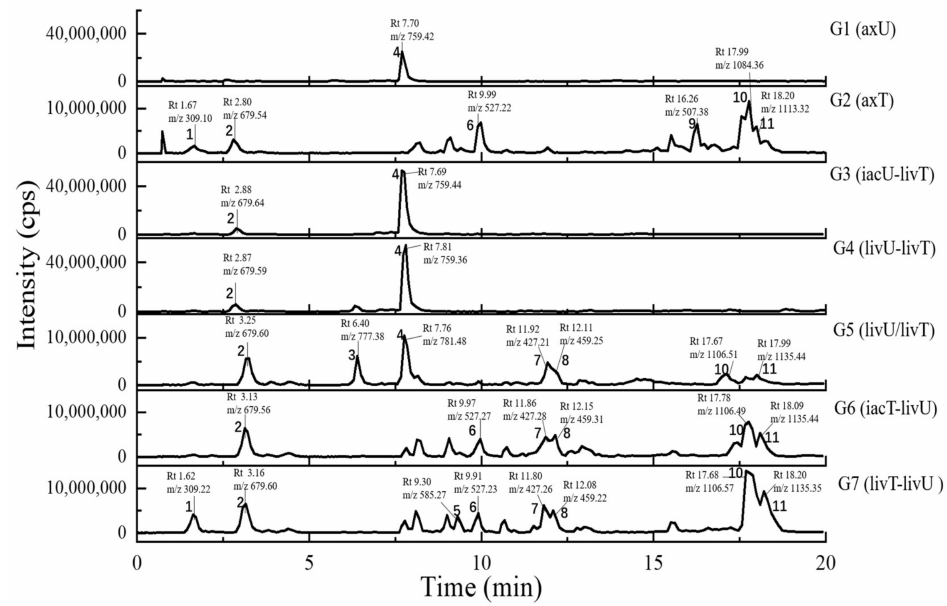
Figure 6. The LC-MS traces (base peak chromatographies, BPC) under positive ion mode of the culture extracts. The samples include axU (G1), axT (G2), iacU-livT (G3), livU-livT (G4), livU/livT (G5), iacT-livU (G6), and livT-livU (G7). The numbers marked on the peaks or in the UV spectra are numbers for the peaks with remarkable yield changes detected by mass spectrometry and are consistent with the peak numbers in Table